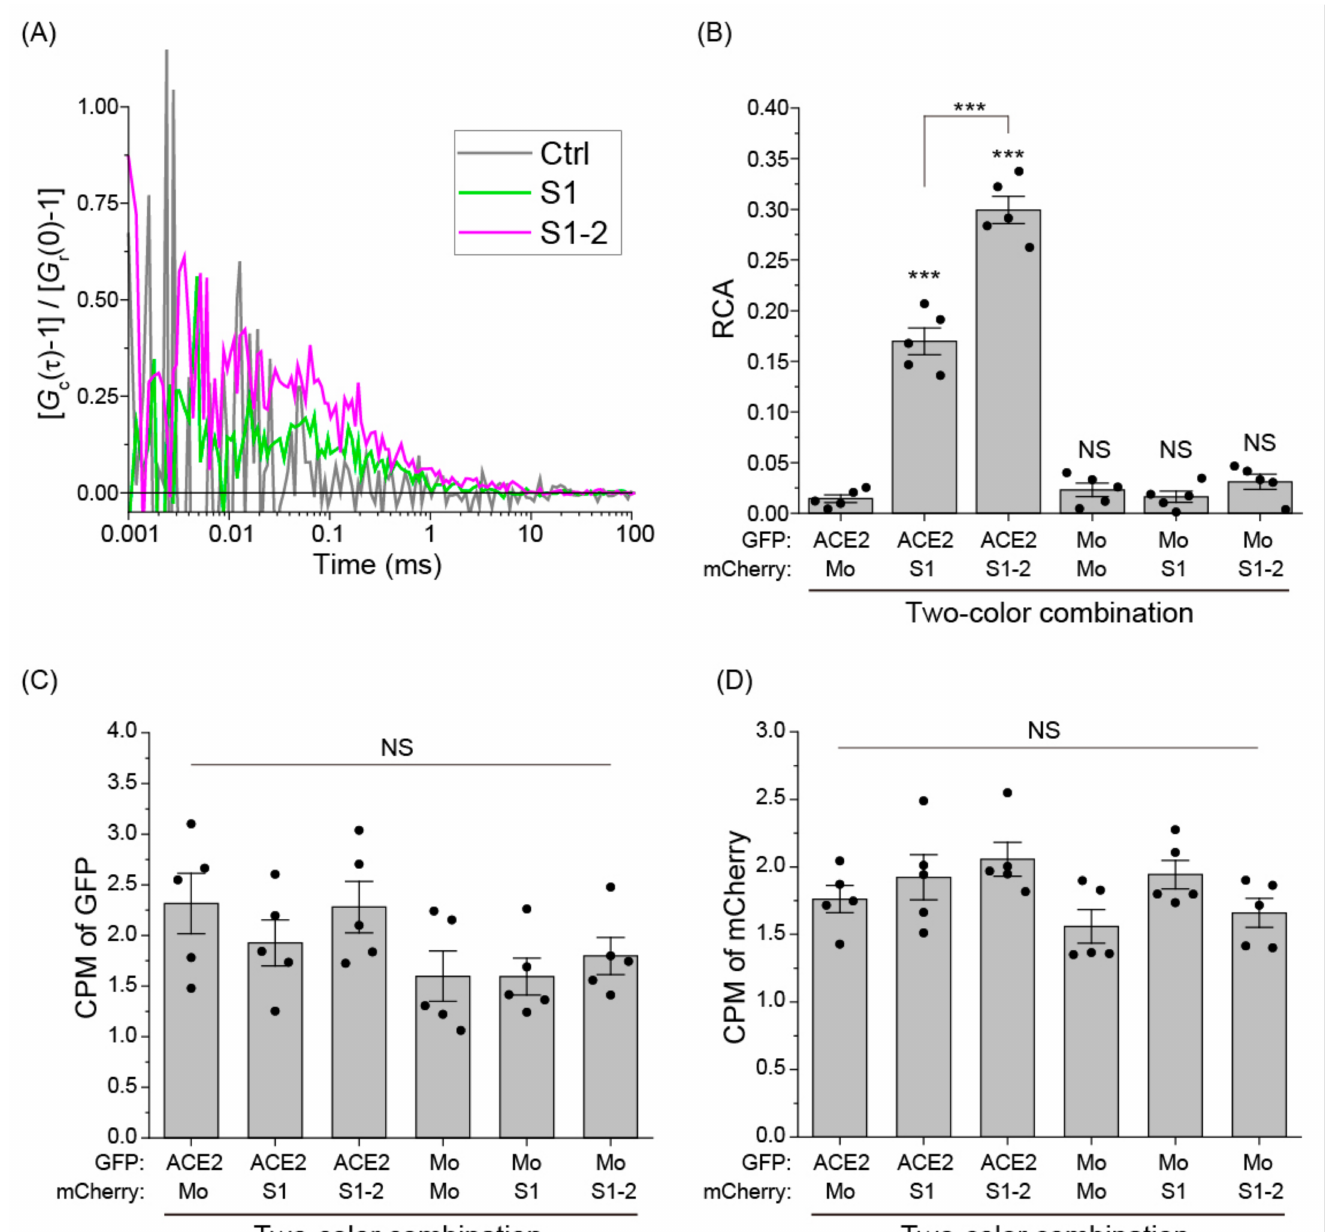
Figure 3. Interaction analysis between ACE2 and S1 subunit using fluorescence cross-correlation spectroscopy (FCCS). ( A ) Typical normalized cross-correlation functions (nCCFs: [ G c ( τ )-1/ G r (0)-1]) of mixtures of purified mCherry monomers (Ctrl; grey), ER-mCherry-S1 (S1; green), or ER-mCherry-S1-2 (S1-2; magenta) with hACE2-eGFP. The x -axis shows time ( τ ). ( B ) Relative cross-correlation amplitudes (RCAs) of mixtures of two fluorescent molecules. Mo indicates GFP or mCherry monomers. Bars indicate mean ± SE. Dots indicate independent values. Statistics: *** p < 0.001, NS: p ≥ 0.05 (not significant); comparison against the mixture including hACE2-eGFP and mCherry monomers as a negative control or line-indicated pairs. ( C ) Counts per molecule (CPM) of eGFP-tagged proteins during FCCS measurement. ( D ) Counts per molecule (CPM) of mCherry-tagged proteins during FCCS